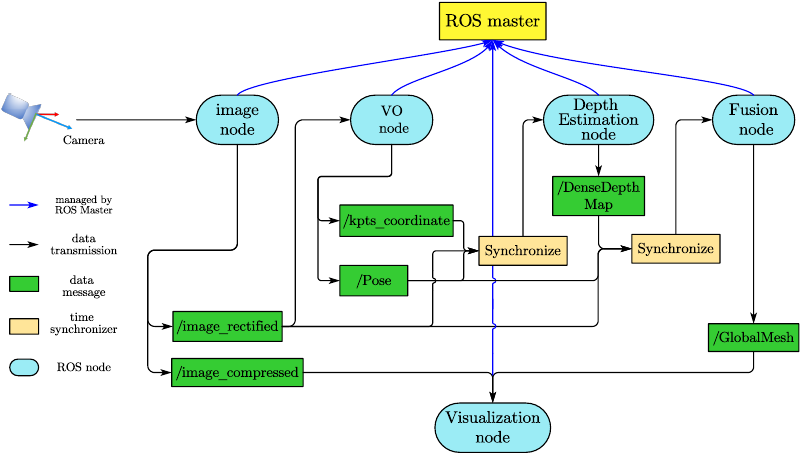
Figure 2. Workflow of ROS-based message passing and